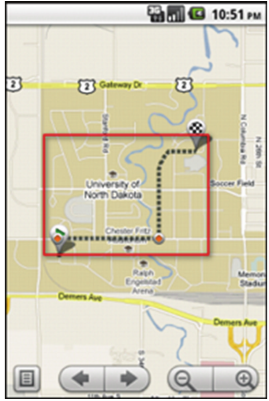
Figure 4: An example of boxing a route.